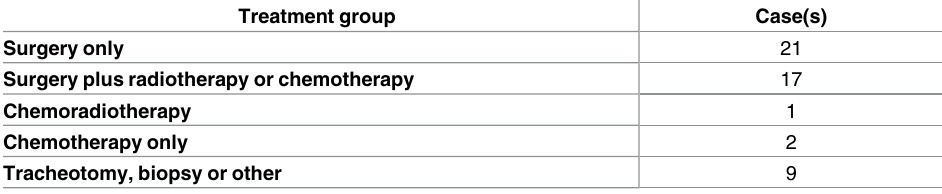
Table 2. Treatment methods of the 50 ATC